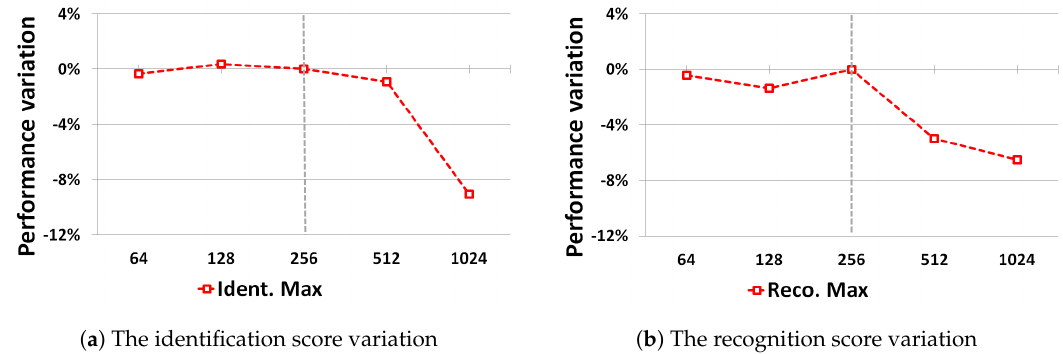
Figure 7. The influence of batch size on the best identification and recognition results on the DR